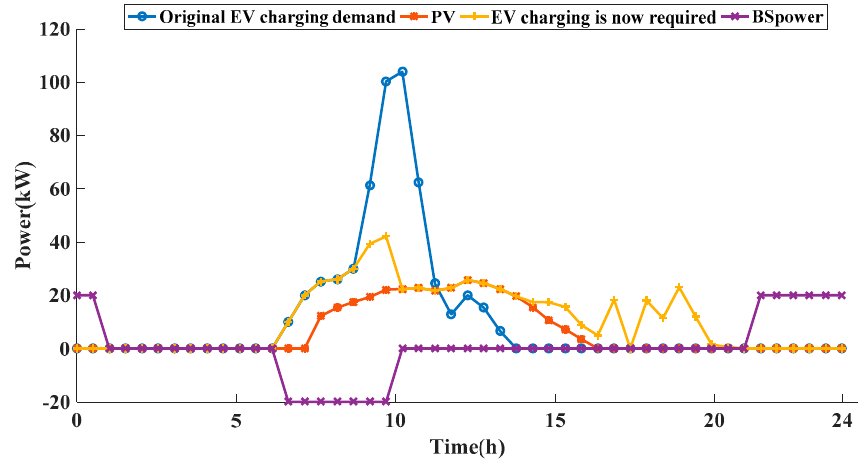
Figure 17. The output of each unit of the parking lot.